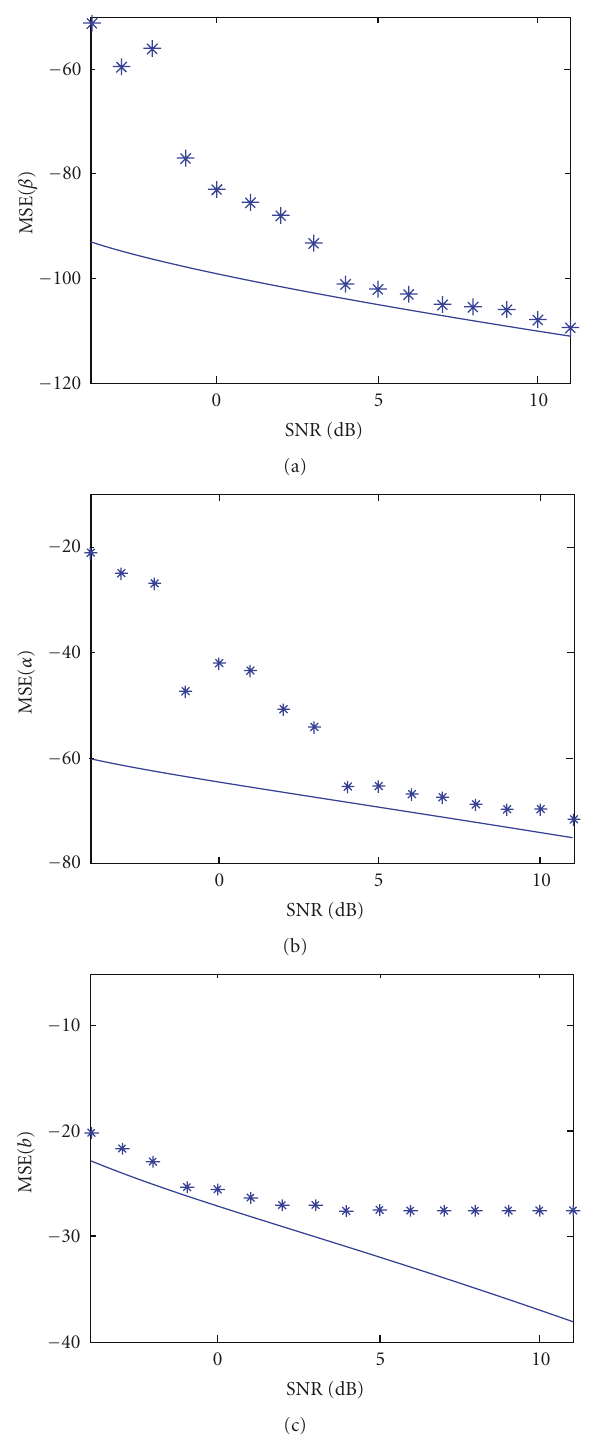
Figure 4: MSEs of parameter estimates of the second component. (Full lines are the theoretical MSEs, and circles indicate measured